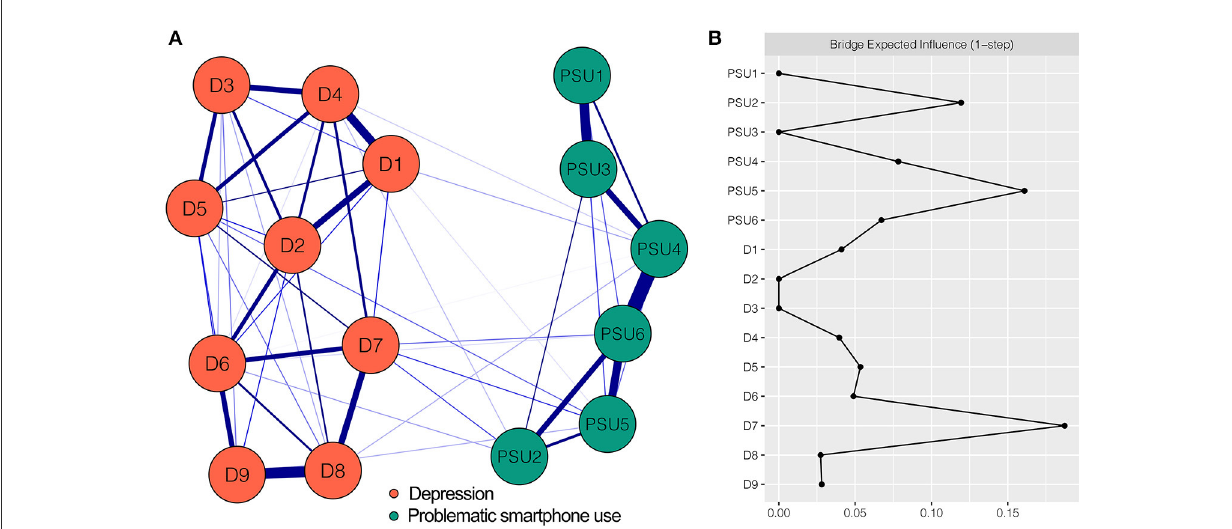
FIGURE2 Network structure of PSU-depression variables and bridge expected influence for each node. (A) The PSU-depression network. Blue edges represent positive correlations. A thicker edge reflects higher correlation between the nodes. (B) The bridge expected influence of each node in the network (raw value). PSU1, Salience; PSU2, Conflict; PSU3, Mood modification; PSU4, Tolerance; PSU5, Withdrawal; PSU6, Relapse; D1, Anhedonia; D2, Depressed or sad mood; D3, Sleep difficulties; D4, Fatigue; D5, Appetite changes; D6, Feeling of worthlessness; D7, Concentration difficulties; D8, Psychomotor agitation/retardation; D9, Thoughts of